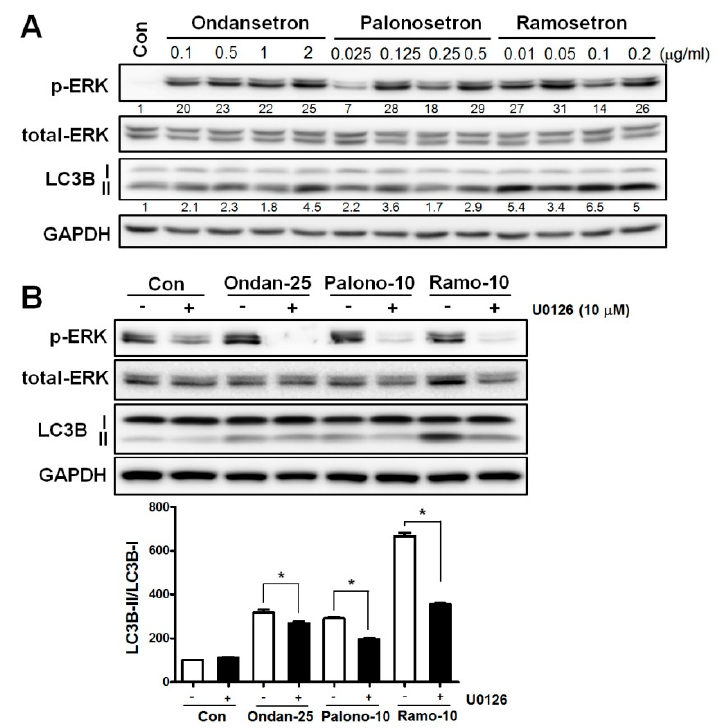
Figure 3. 5-HT3 receptor antagonists induce autophagy via extracellular signal-related kinase (ERK) activation in lung cancer cells. ( A ) Levels of phospho-ERK, total-ERK, light chain 3B (LC3B), and autophagy-related 16 like 1 (ATG16L1) were determined by Western blotting. Glyceraldehyde-3-phosphate dehydrogenase (GAPDH) served as a loading control. ( B ) A549 cells were treated with or without ERK inhibitor (U0126, 10 mM) before a 1-h treatment with 5-HT3 receptor antagonist. Levels of phospho-ERK, total-ERK, and LC3B were determined by Western blotting. GAPDH served as a loading control; * p < 0.05.